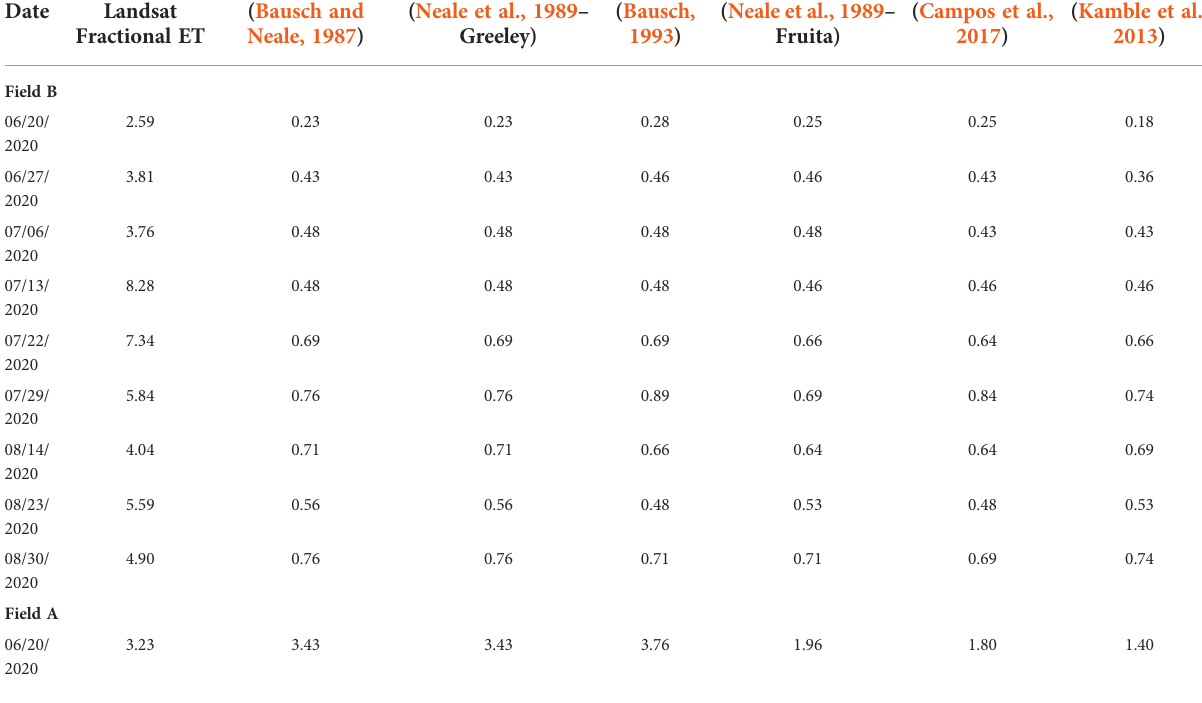
TABLE 2 Whole fi eld actual evapotranspiration estimates calculated based on seven different crop coef fi cient